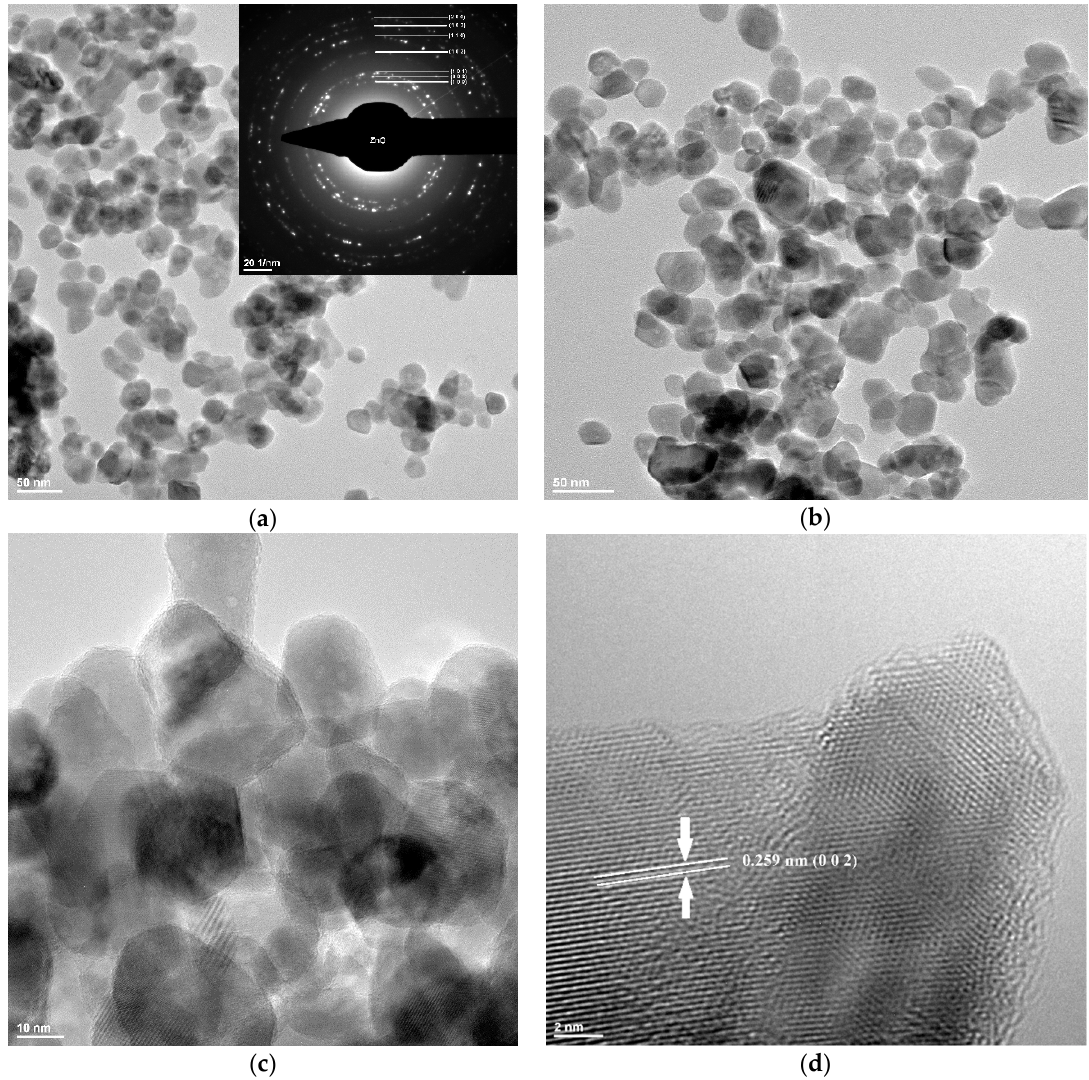
Figure 1. TEM ( a – c ) and high-resolution transmission electron microscopy (HRTEM) ( d ) images for ZnO nanoparticles.